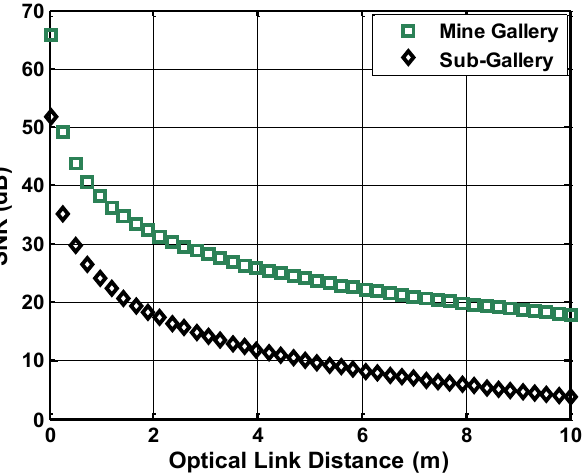
Figure 13. Estimation of the signal to noise ratio (SNR) for the integrated LOS and NLOS VLC links. Therefore, the plotted value of SNR is better in the environment of the mine gallery. The maximum to minimum obtained range of SNR is 67 dB to 17 dB and 51 dB to 4 dB for the mine gallery and sub-gallery,